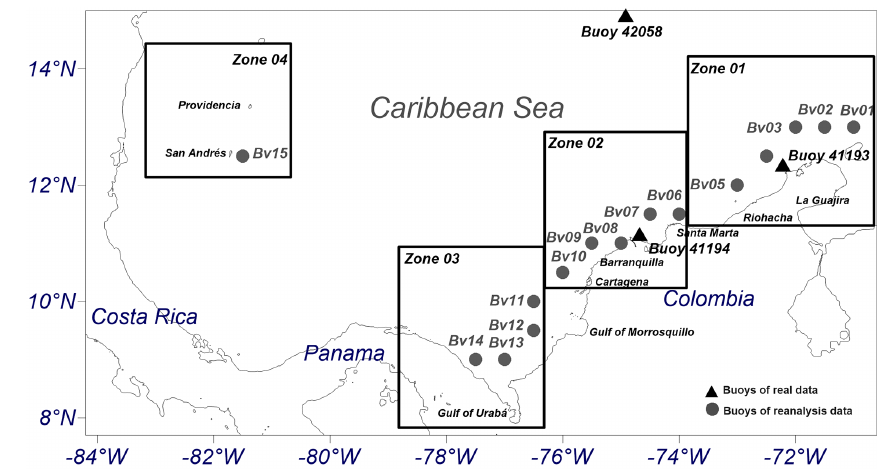
Figure 1. Location of the DIMAR and NOAA buoys on the Colombian Caribbean coast, and location of the 15 virtual buoys generated using WW3, including the zoning proposed by Ortiz (2012) based on the threat degree of